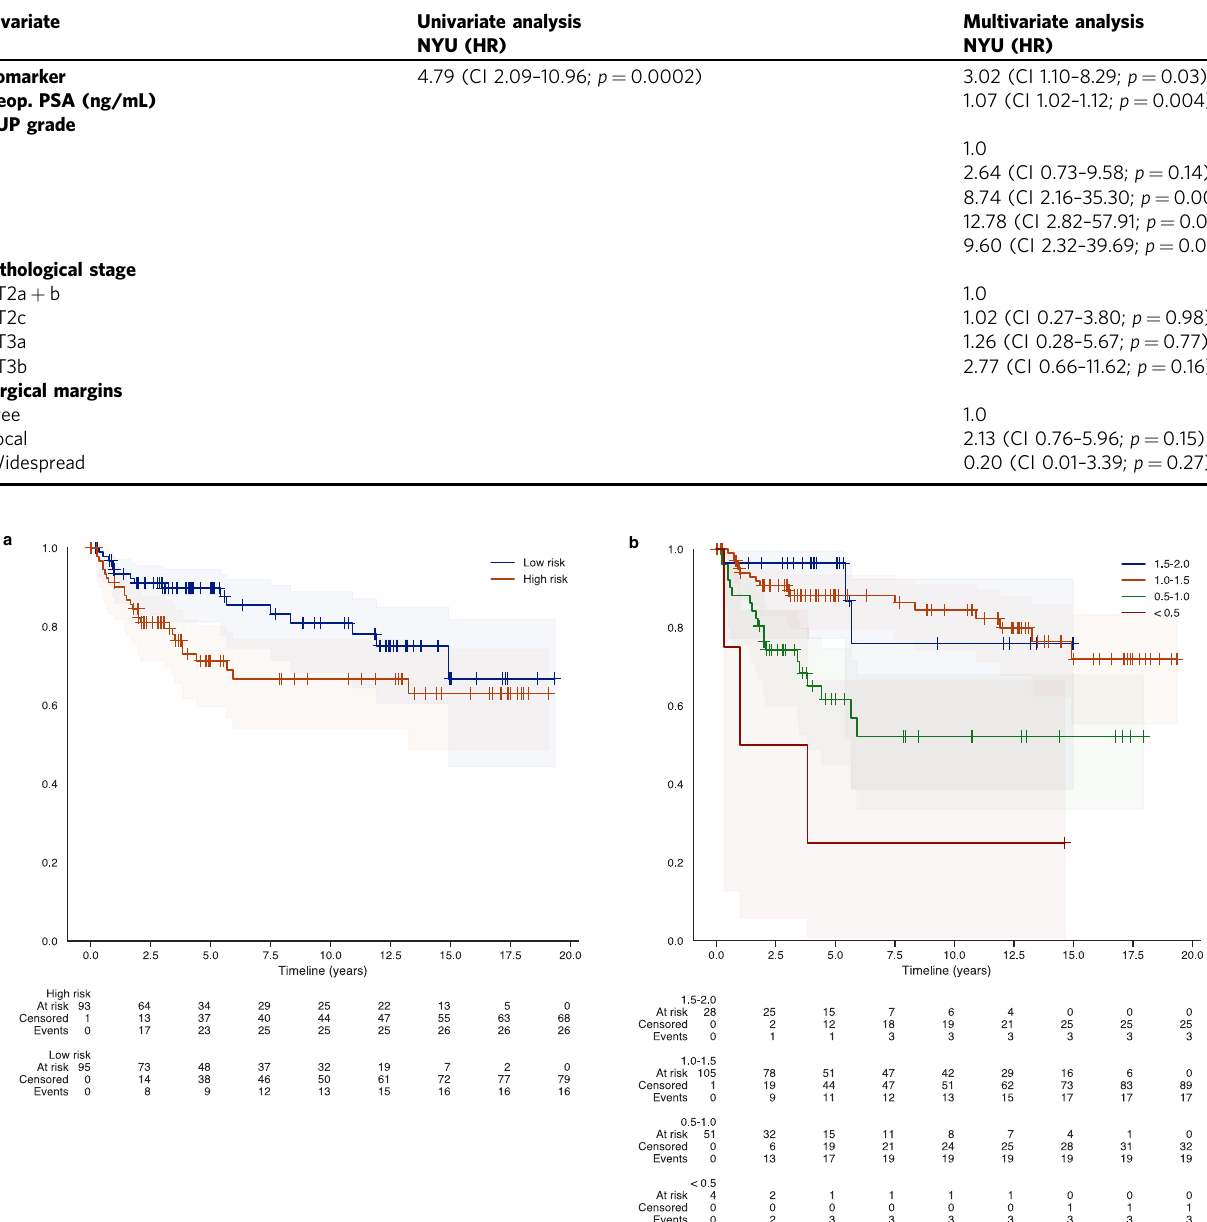
Table 4 Cox proportional hazard analyses of New York Langone external validation cohort.